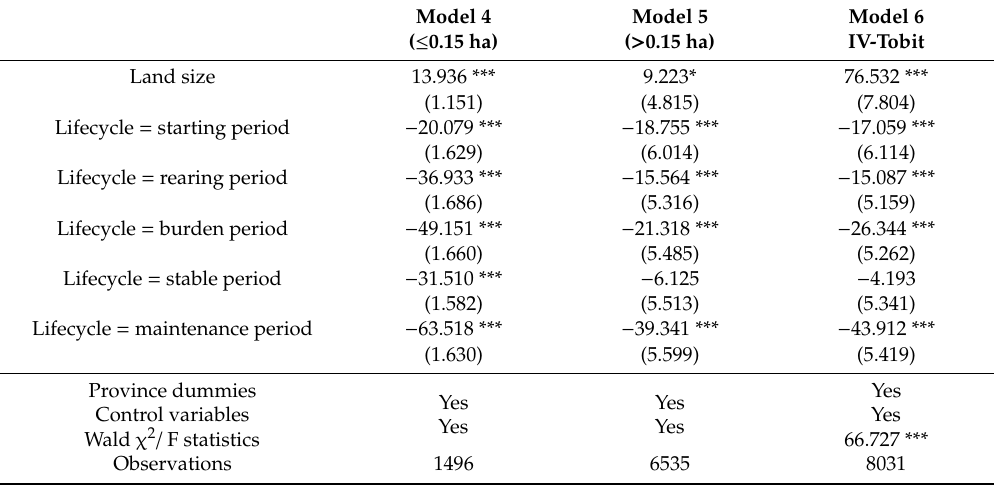
Table 6. Model robustness test